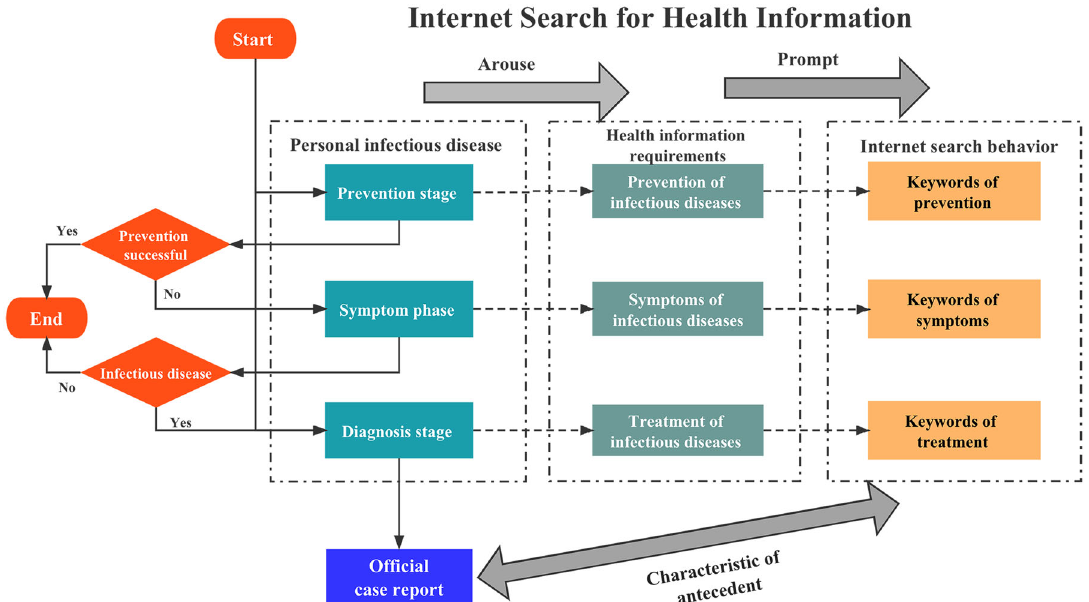
Fig. 1 Leading features of Internet multisource big data. During the prevention, identi fi cation of symptoms, and diagnosis of infectious diseases, individuals will spontaneously generate health information search behaviour, thus generating Internet search behaviour data. Compared with of fi cial case monitoring, Internet search data are proactive and